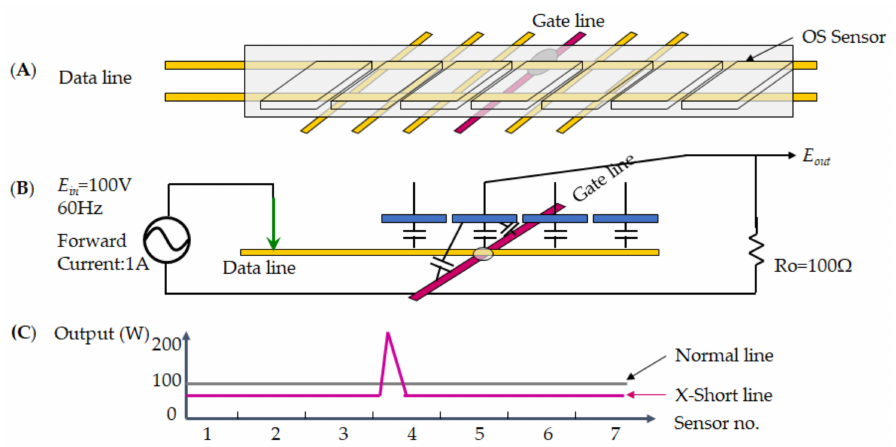
Figure 9. An X-short defect presents on the electrical signal for TFT, which ( A ) metal line, ( B ) measurement voltage, and ( C ) power distribution.